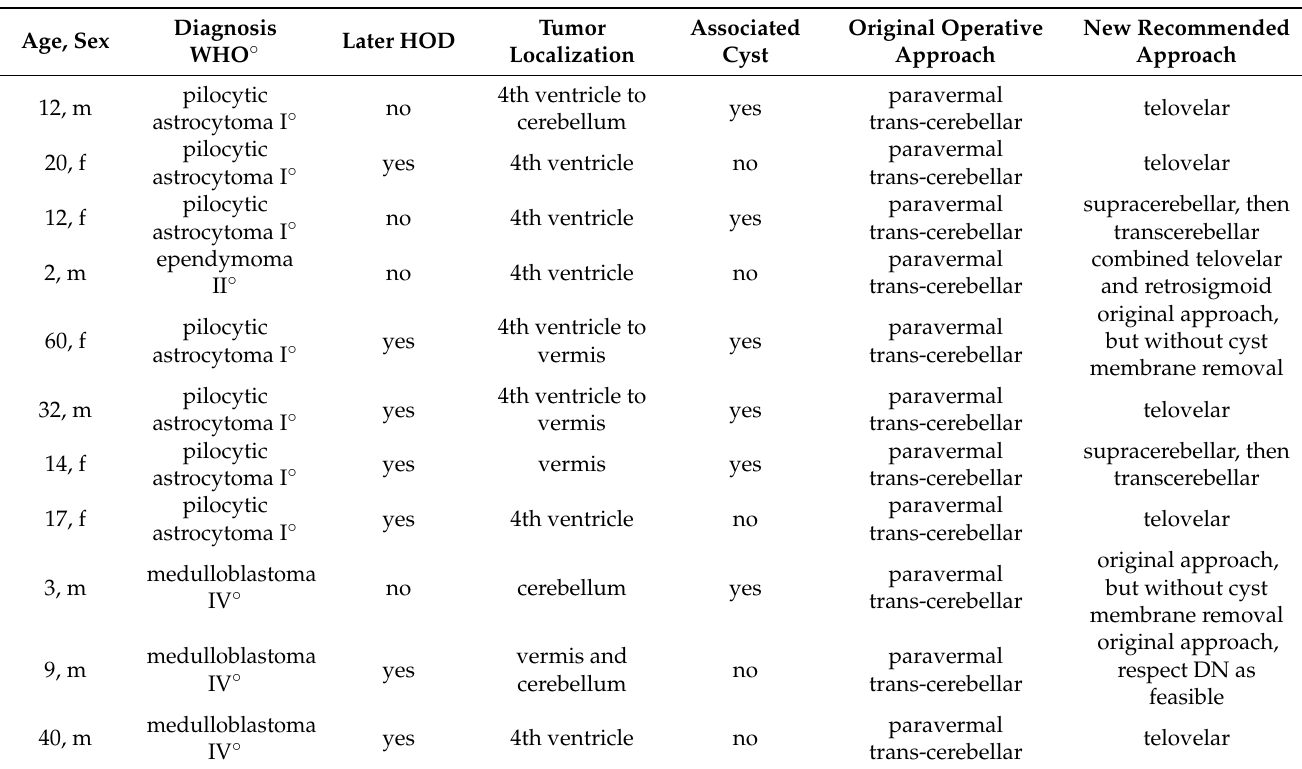
Table A3. New recommended approaches in retrospective analysis of the preoperative situations of all eleven patients with a paravermal trans-cerebellar approach in this study. Later HOD refers to the occurrence of HOD on cMRI within 12 month-follow up. Abbreviations: DN = dentate